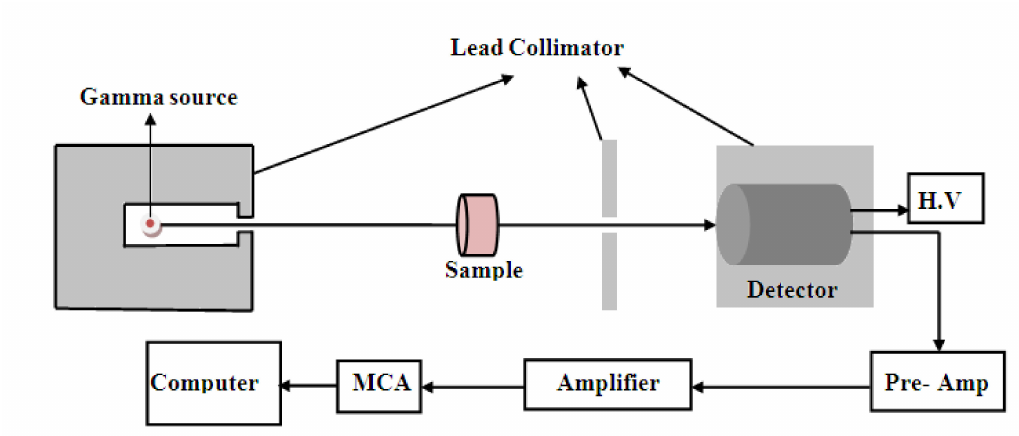
Figure 1. The experimental setup for the determination of the mass attenuation